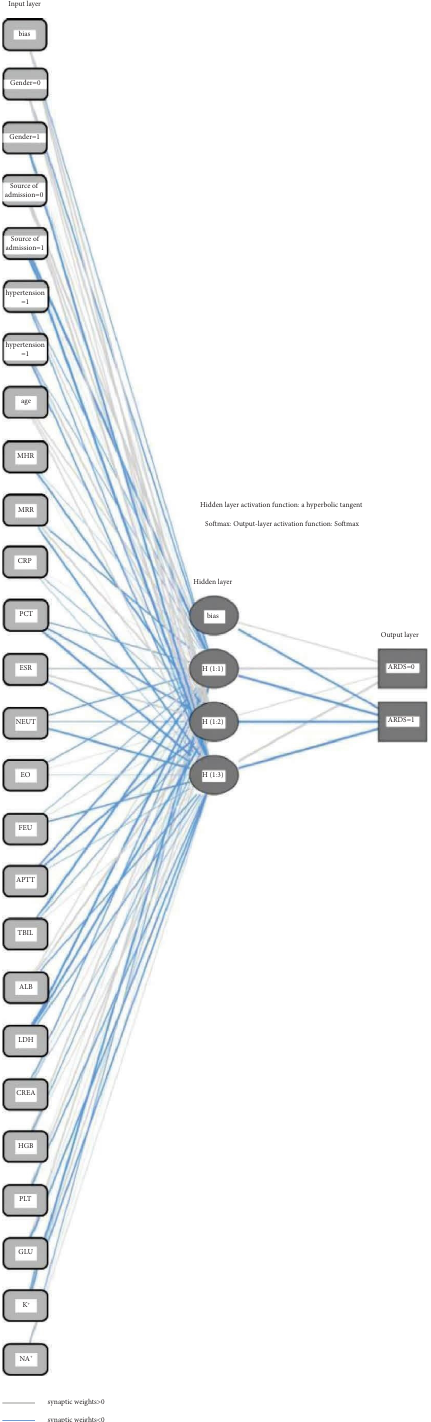
Figure 2: Topological stratifcation structure of the ARDS prediction model in CAP patients based on an artifcial neural network model. Note. CAP, community-acquired pneumonia; ARDS, acute respiratory distress